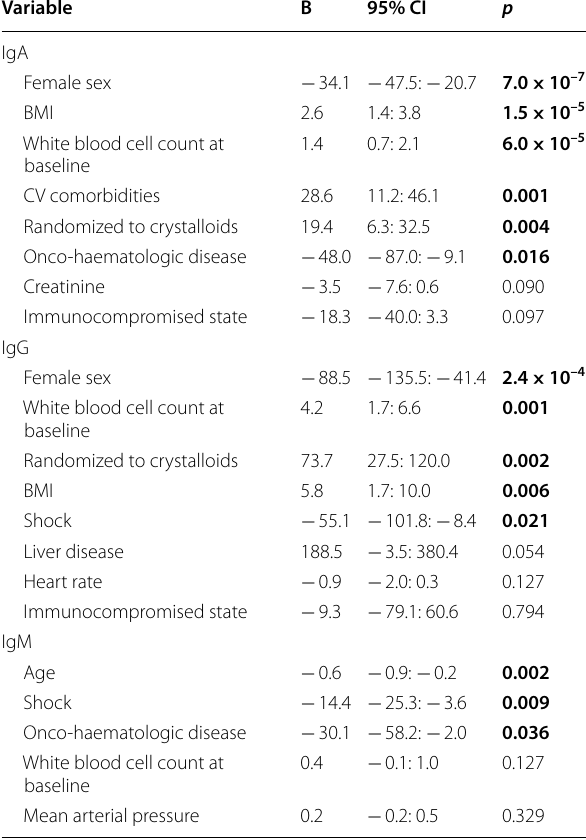
Output for multivariable linear regression analysis with continuous Ig concentration as dependent variable Included in the regression analyses are the variables which were significant in Additional file 1: Tables S1, S2 and S3. For IgG, AIDS was not included due to confounding by immuno-compromised state. Location of infection was not included in this